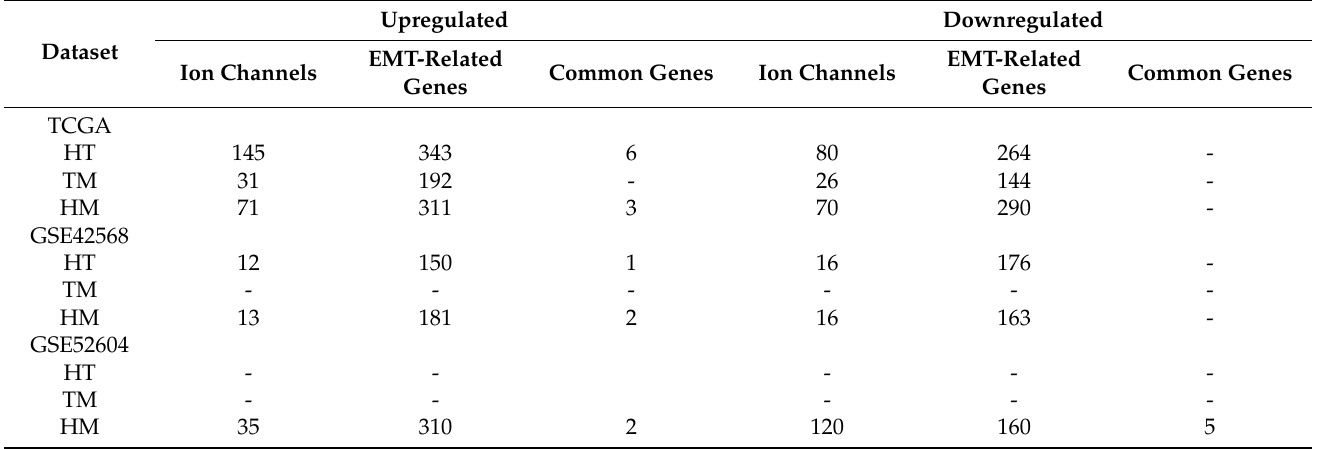
Table 1. A list of total upregulated and downregulated ion channels and EMT-related genes in